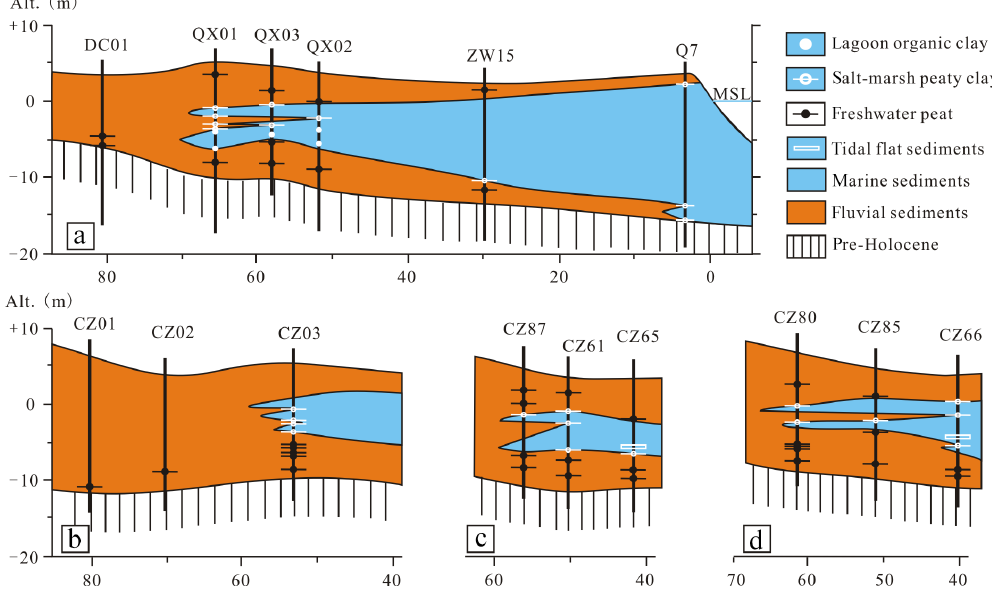
Figure 5. The lithostratigraphy of transects B, C and D, with details of dated sedimentary horizons.